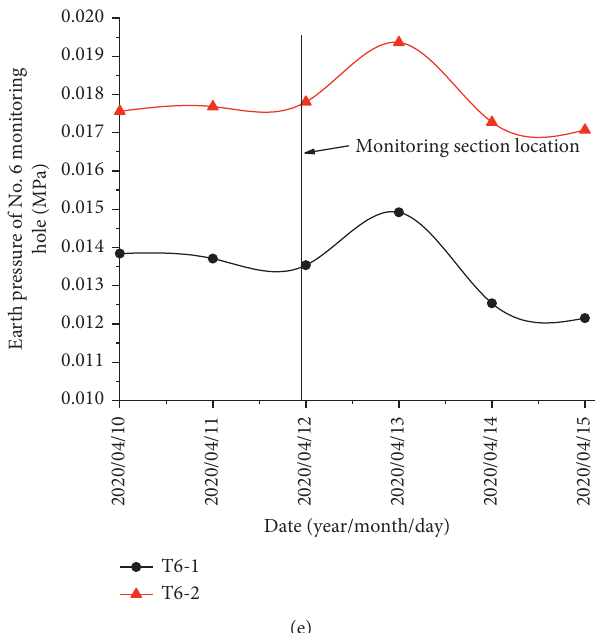
Figure 13: Variation diagram of earth pressure during Hole 2 jacking. (a) Earth pressure of No. 2 monitoring hole. (b) Earth pressure of No. 3 monitoring hole. (c) Earth pressure of No. 4 monitoring hole. (d) Earth pressure of No. 5 monitoring hole. (e) Earth pressure of No. 6 monitoring